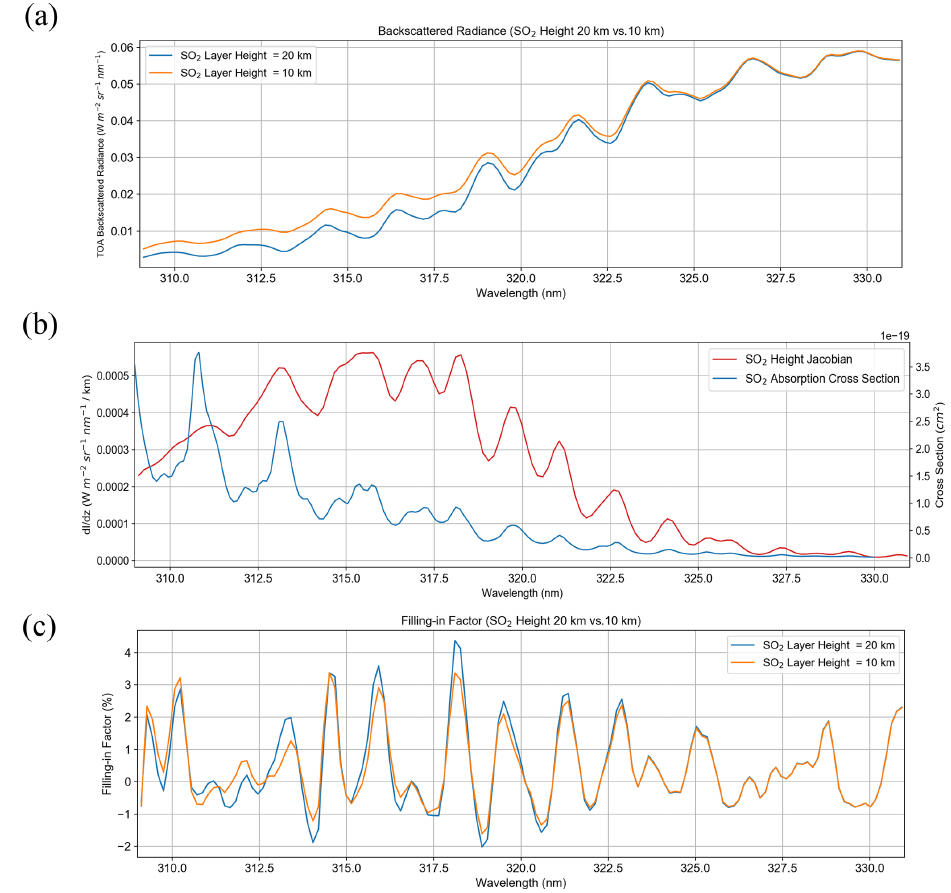
Figure 2. (a) Simulated top-of-the-atmosphere (TOA) Earthshine radiances for two different SO 2 layer heights (10 and 20km) from the LIDORT-RRS model. Also shown: (b) the SO 2 height Jacobian (change in radiance per kilometer between the two spectra) along with the absorption cross sections of SO 2 for reference; (c) the filling-in factor. The filling-in factor is defined as the difference between the total and elastic-only radiance results divided by the total radiance and expressed as a percentage. An SO 2 column amount of 200DU was used in the two calculations, and all other parameters were kept constant except for the SO 2 layer height. Table 2. The RMSE and the mean absolute difference (km) of all data points in the independent test set after adding noise as indicated by different SNR values. All other parameters and input data were kept constant. SZA < 75 ◦ and SO 2 VCD > 40DU were excluded from the test set for these comparisons. No noise SNR =